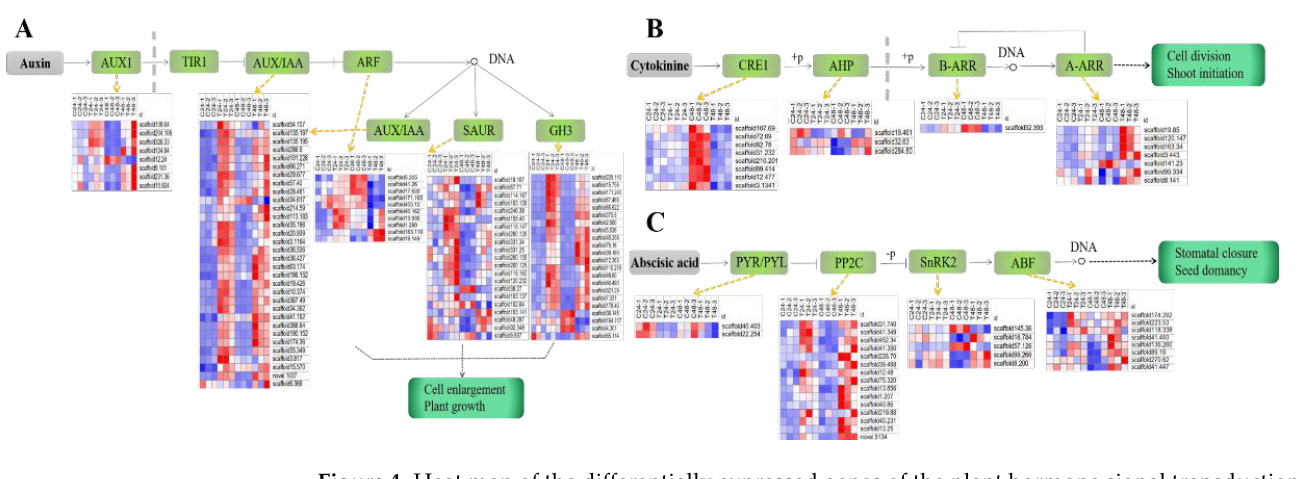
Figure 4. Heat map of the differentially expressed genes of the plant hormone signal transduction pathway. The different expressed genes are defined as |log2FoldChange| > 1 and Padj < 0.05. ( A ) is auxin signal transduction pathway, ( B ) is cytokinin signal transduction pathway, and ( C ) is abscisic acid signal transduction pathway. C24-1, C24-2, and C24-3: the control group at 24 h (three repetitions); C48-1, C48-2, and C48-3: the control group at 48 h (three repetitions); T24-1, T24-2, and T24-3: the treatment group (50 mg/L dihydrocoumarin) at 24 h (three repetitions); and T48-1, T48-2, and T48-3: the treatment group (50 mg/L dihydrocoumarin) at 48 h (three repetitions).